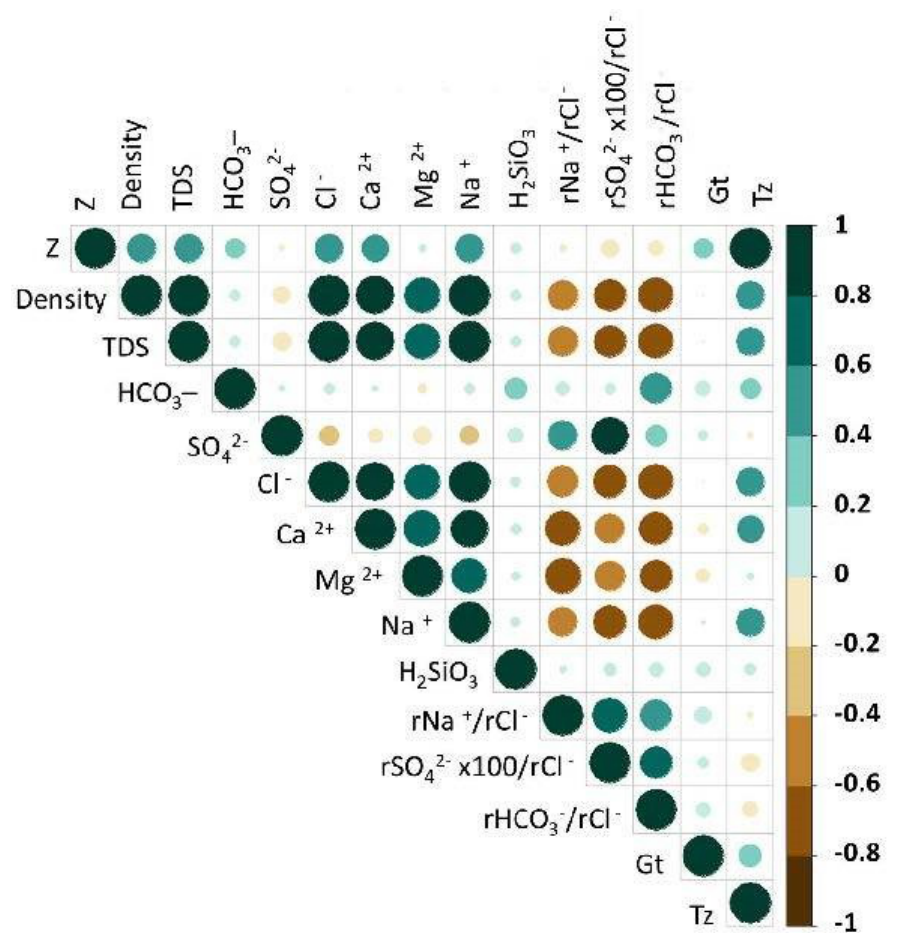
Figure 8. The correlation matrix based on Spearman’s rank correlation